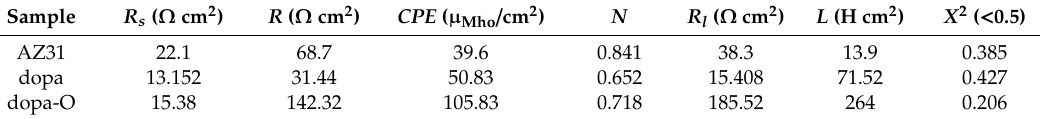
Table 1. The extracted impedance data from equivalent electrical circuit. CPE, constant phase element.